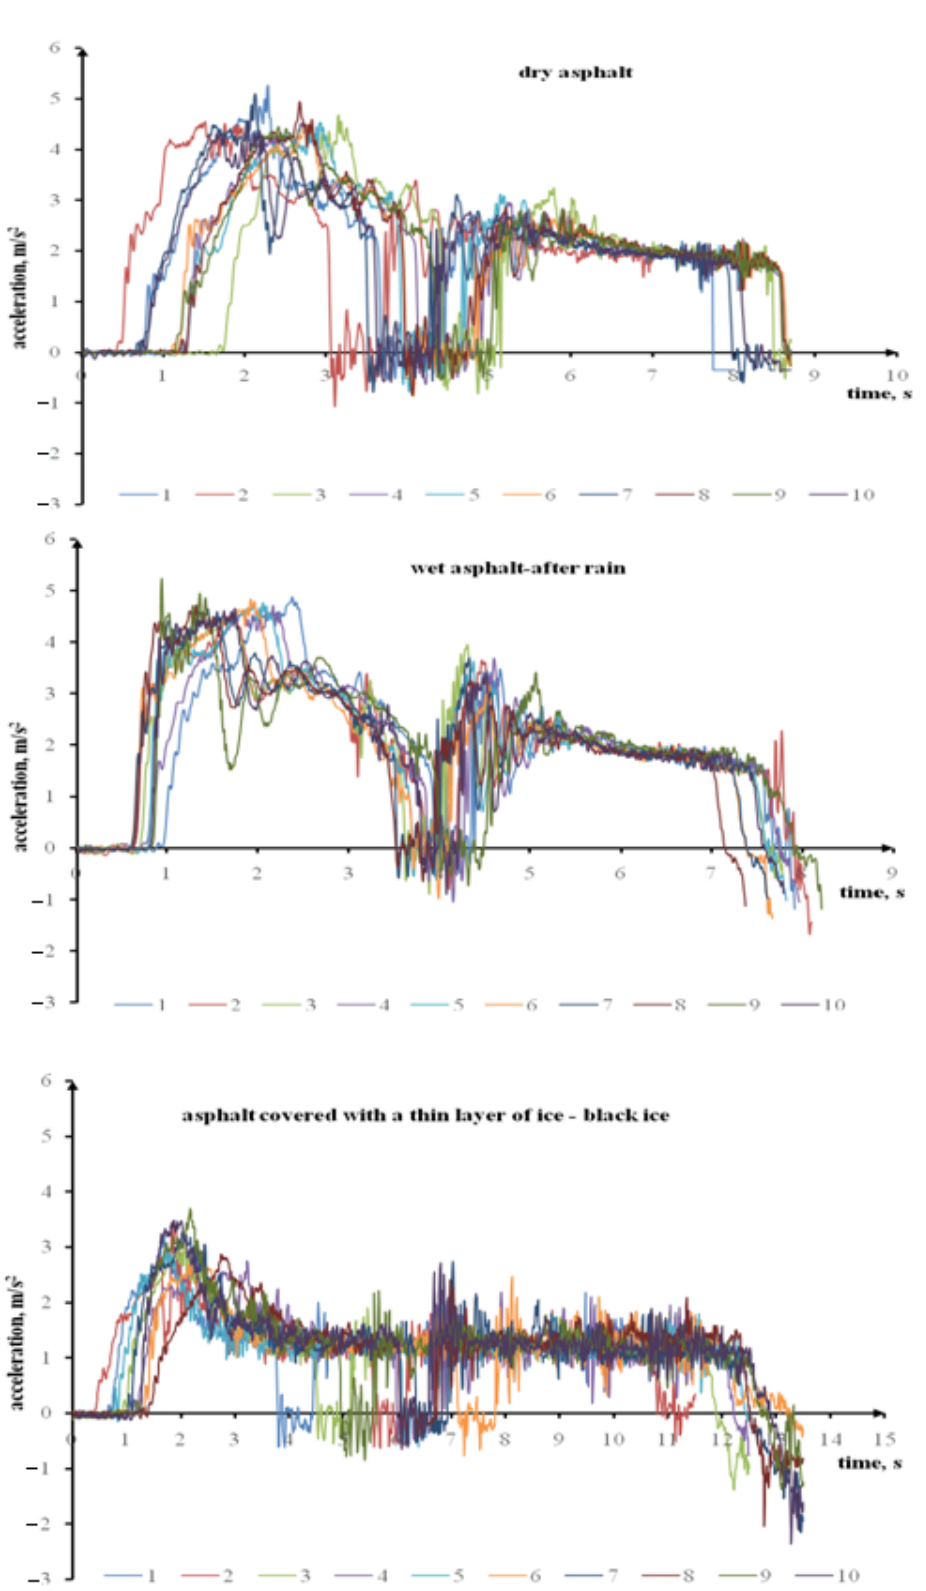
Figure 4. The Ford Transit’s longitudinal acceleration during rapid acceleration on a dry surface, a wet (after rain) asphalt surface, and an asphalt surface covered with a thin layer of ice.